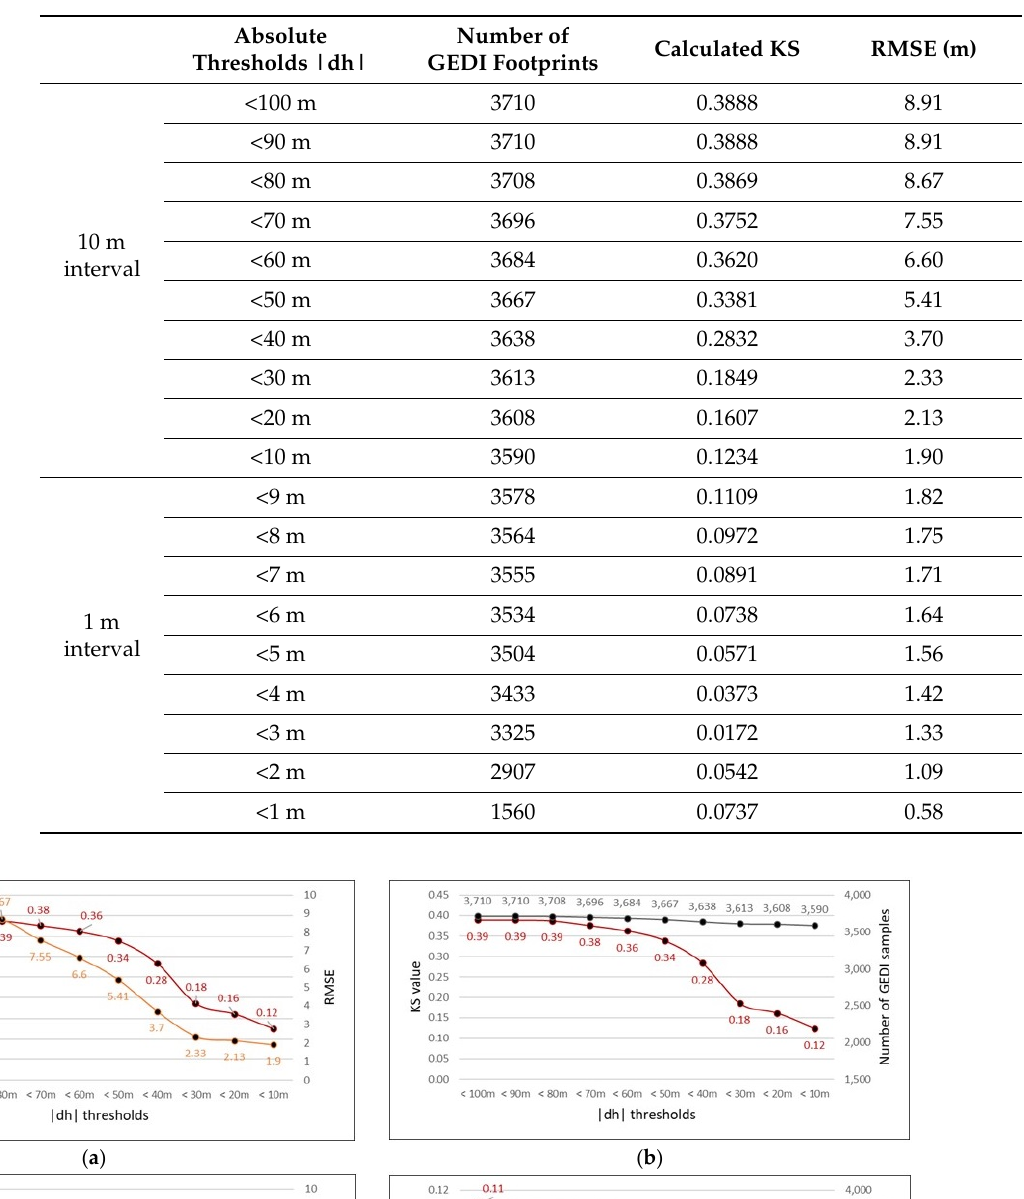
Table 3. Statistics from pre-defined thresholds of absolute value of dh-DTM.